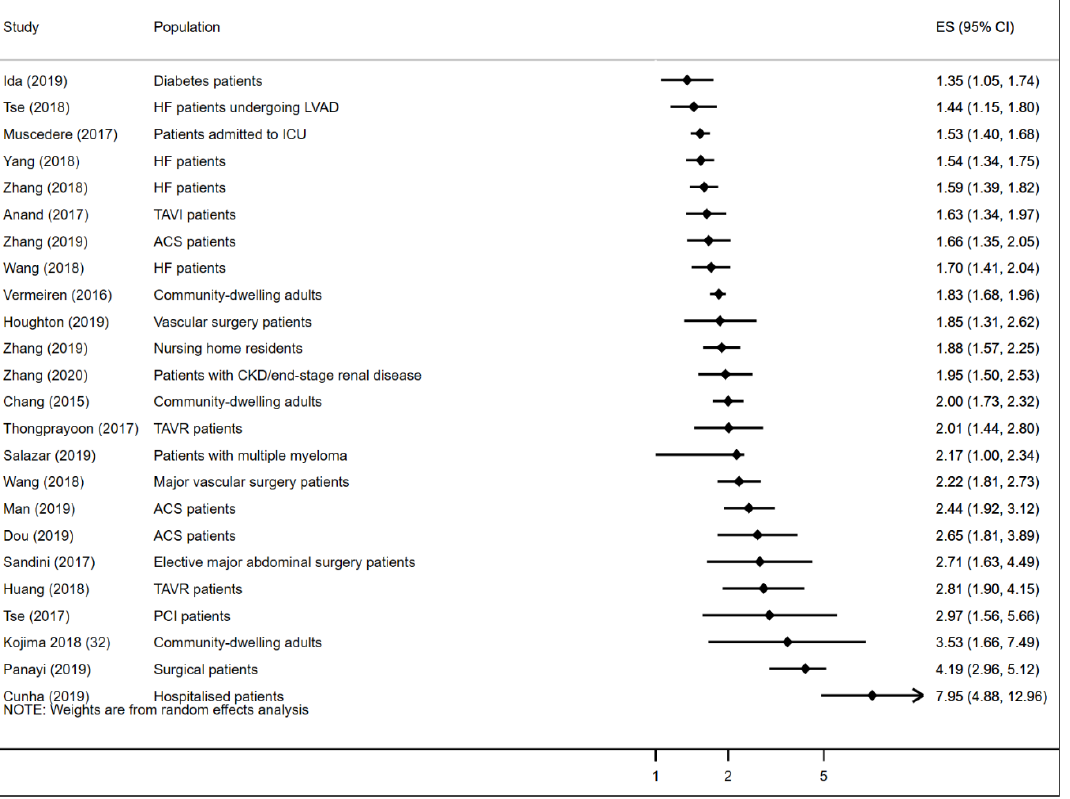
Figure 2. Forest plot showing the reported HR/RR of the association between frailty and all-cause mortality across the included meta-analyses. HF = heart failure; ACS = acute coronary syndrome; PCI = percutaneous coronary intervention; TAVI = TAVI = transcatheter aortic valve implantation patients; TAVR = transcatheter aortic valve replacement, LVAD = left ventricular assist device implantation; ICU = intensive care unit.